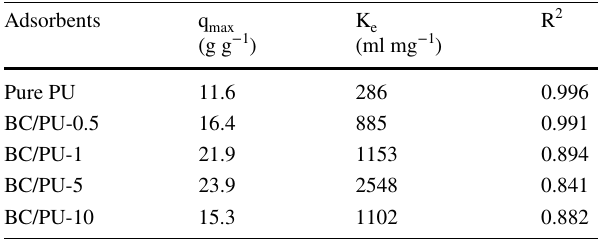
Table 4 Langmuir isotherm parameters for pure PU foam and